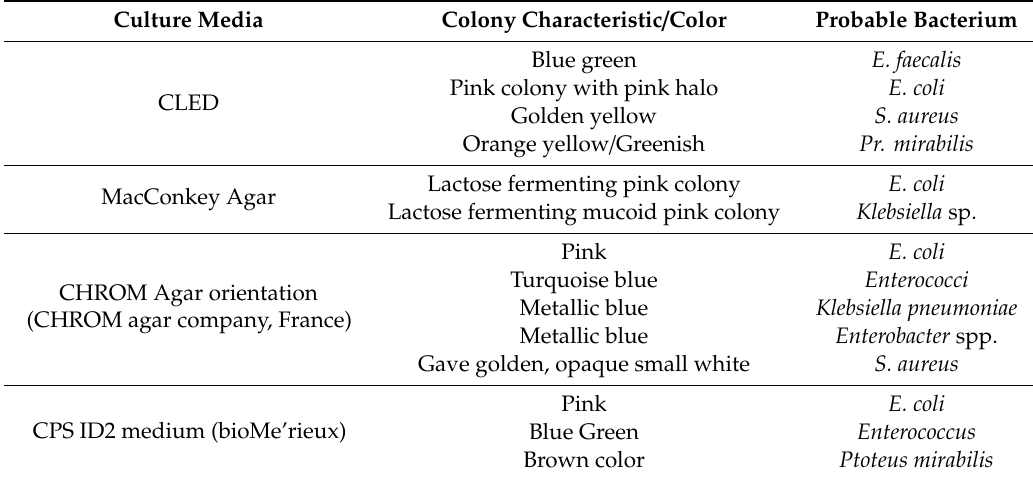
Table 1. Colony characteristics of uropathogens on selective